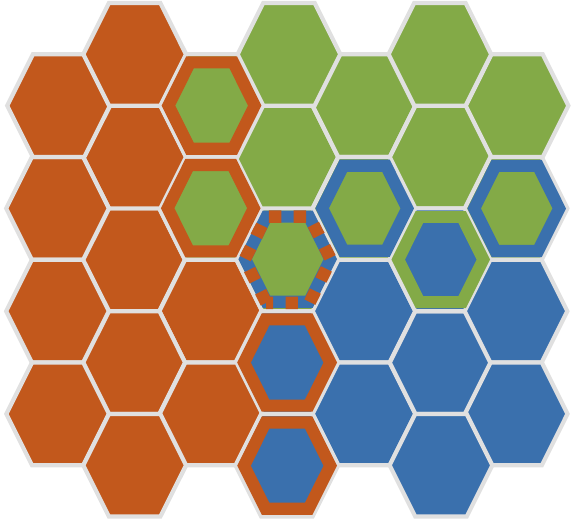
Figure 6: Physics simulation scale-out enabled by DGGS.